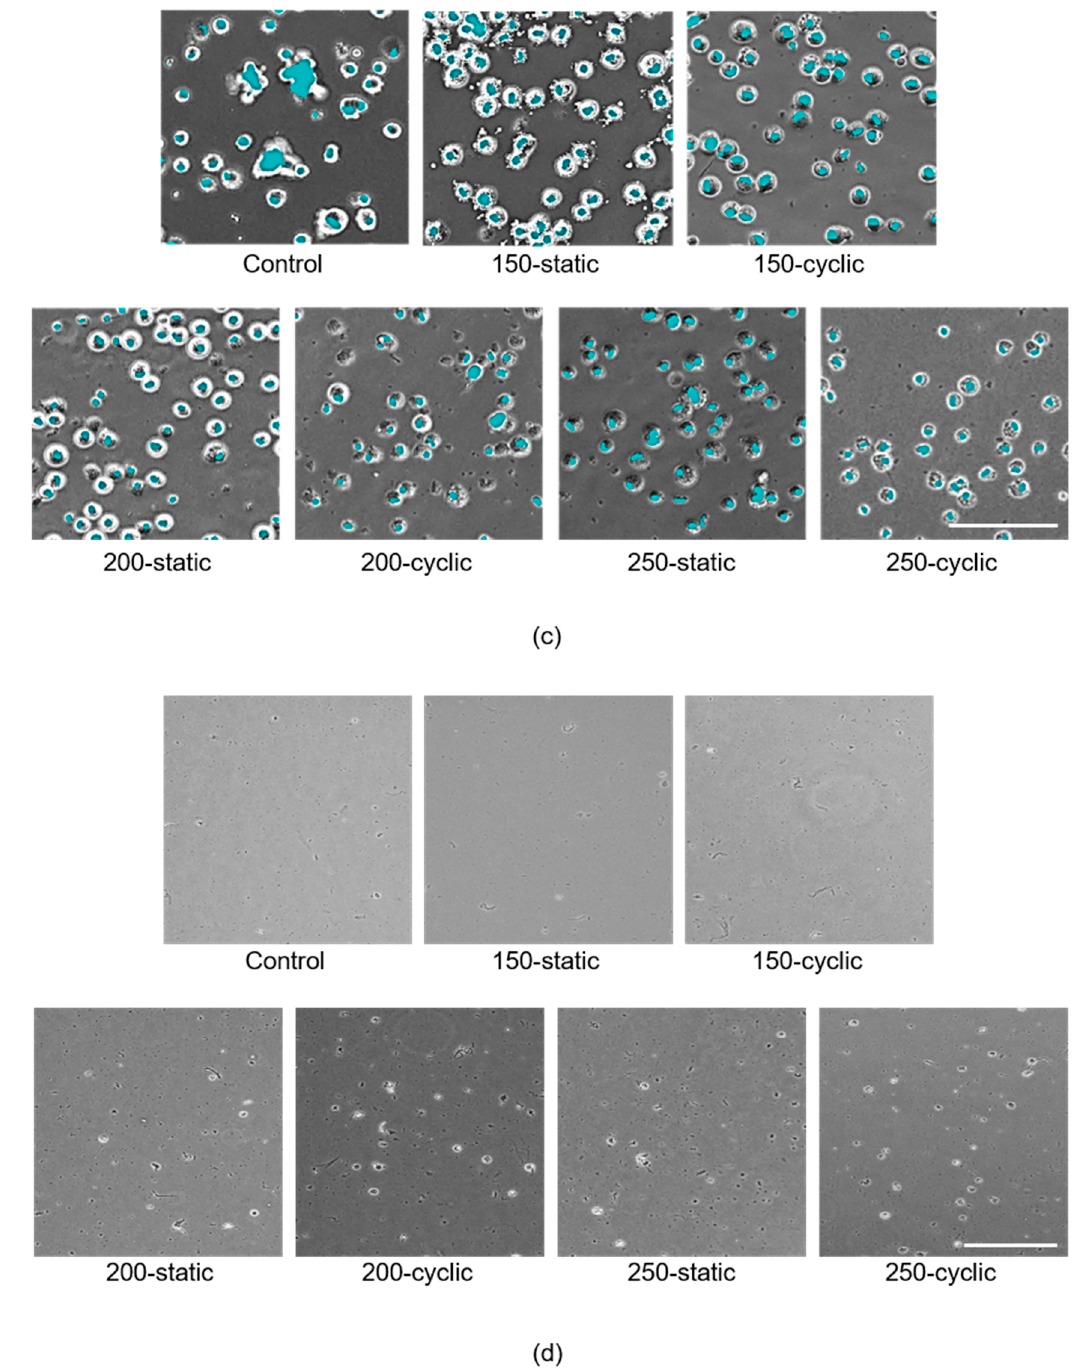
Figure 4. Evaluation of damage to cell membrane and nucleus of NB1RGB cells. ( a ) Phase-contrast images of NB1RGB cells precipitated by centrifugation. Scale bar: 200 μ m. ( b ) Scanning electron microscopy images precipitated by centrifugation. Scale bar: 5 μ m. ( c ) Hoechst staining precipitated by centrifugation. Scale bar: 100 μ m. ( d ) Phase-contrast images of the supernatant. Scale bar: 300 μ m.